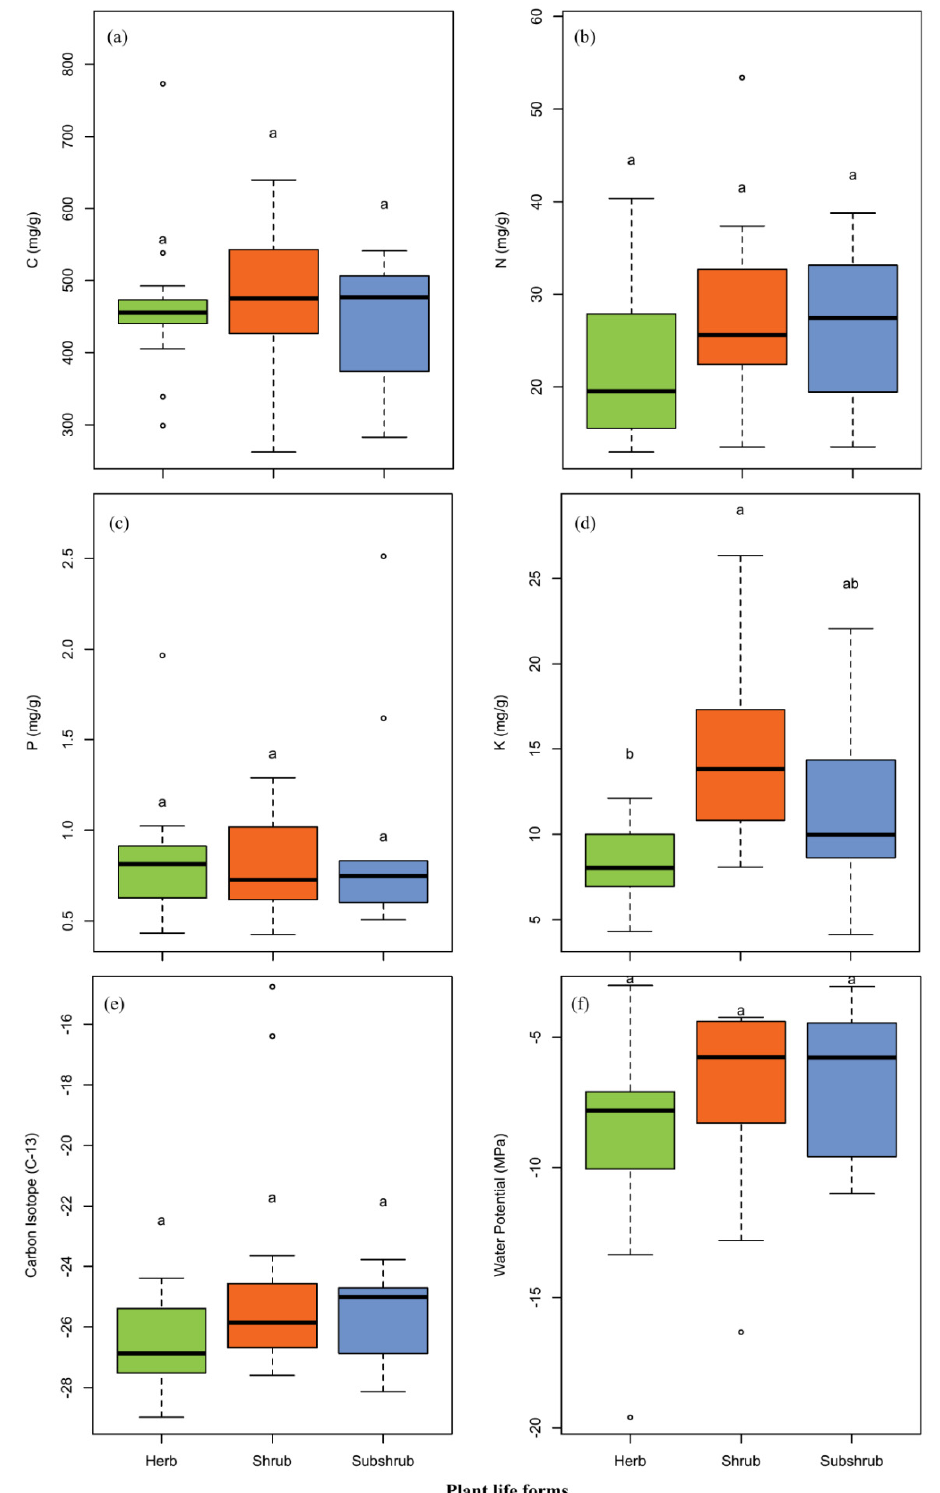
Figure 2. Leaf traits data for species in different life forms (such as herb, shrub, subshrub): ( a ) leaf carbon concentration (C); ( b ) leaf nitrogen concentration (N); ( c ) leaf phosphorus concentration (P); ( d ) leaf potassium concentration (K); ( e ) carbon isotope C 13 concentration ( δ 13 C) and; ( f ) leaf water potential ( Ψ l ). Data presented beyond whiskers represent outliers and letters indicate significant level ( p < 0.05) among life forms (Tukey’s HSD test).